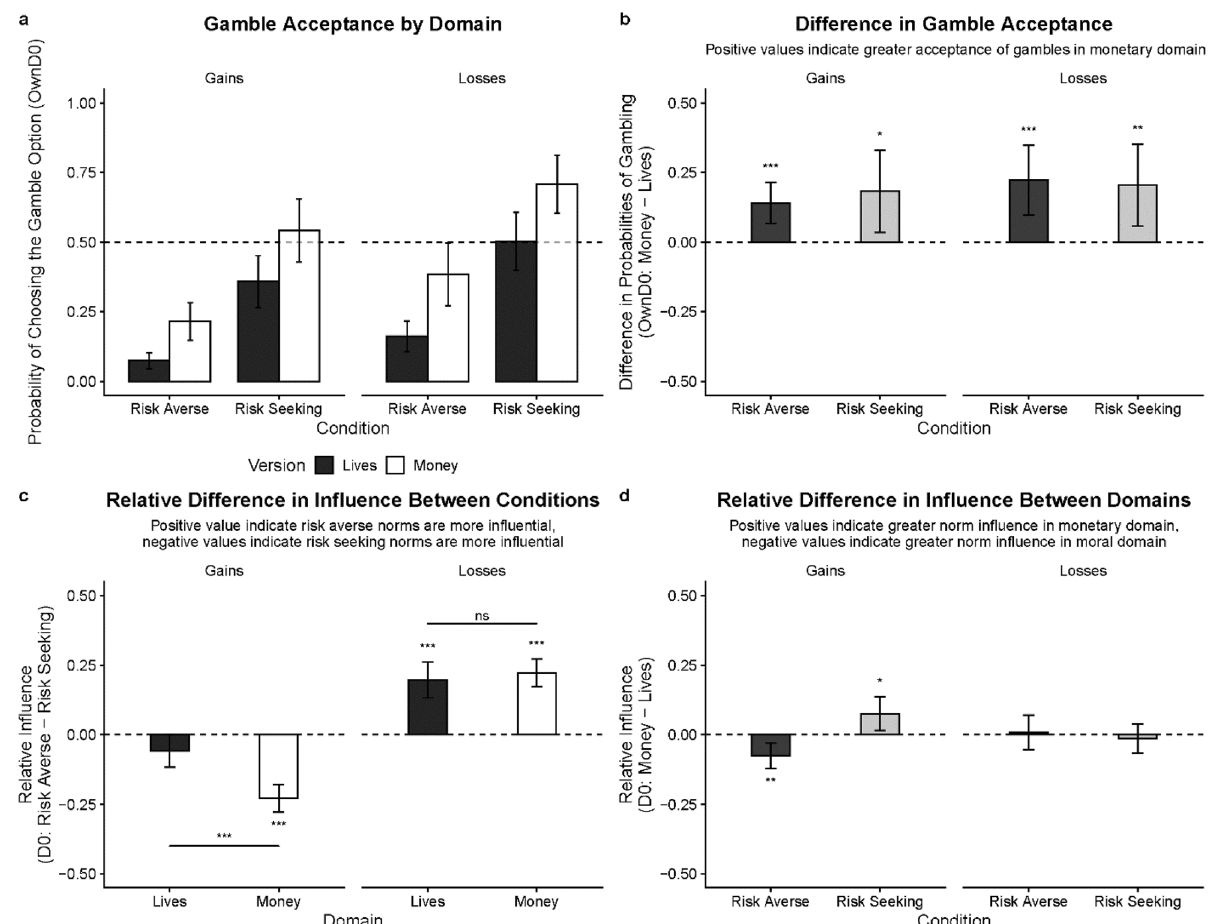
Figure 6. Comparisons between Experiment 1 and Experiment 2. ( a ) Marginal probabilities of endorsing the gamble option in the OwnD0 phase in the moral (Experiment 1) and monetary (Experiment 2) version of the gamble task. ( b ) Probability differences of endorsing a gamble between moral and monetary versions of the task at the OwnD0 phase for each experimental condition. ( c ) Differences in the average amount of influence between risk-averse and risk-seeking conditions. Presented are results based on the data collected from individuals who completed the session on day 0 (D0). ( d ) Differences in the average amount of influence between moral and monetary task versions for each experimental condition. Error bars represent 95% Confidence Intervals (95% CI). * p < .05, ** p < .01, *** p <